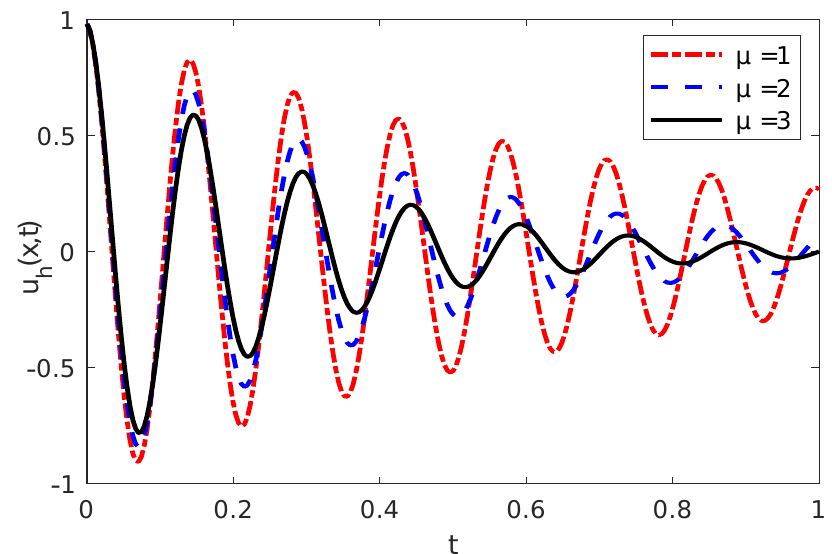
Figure 7. Graph of u h ( x , t ) at the midpoint over time for different values of µ . Next, we fixed µ = 3, changed the value of α and observed the vibration curve at the midpoint of the damping beam. It can be seen from Figure 8 that the attenuation rate of the beam vibration decreases with the increase in the order of the fractional derivative. In addition, it is generally shown that the peaks of these curves gradually increase and shift to the right as the order of the fractional derivatives